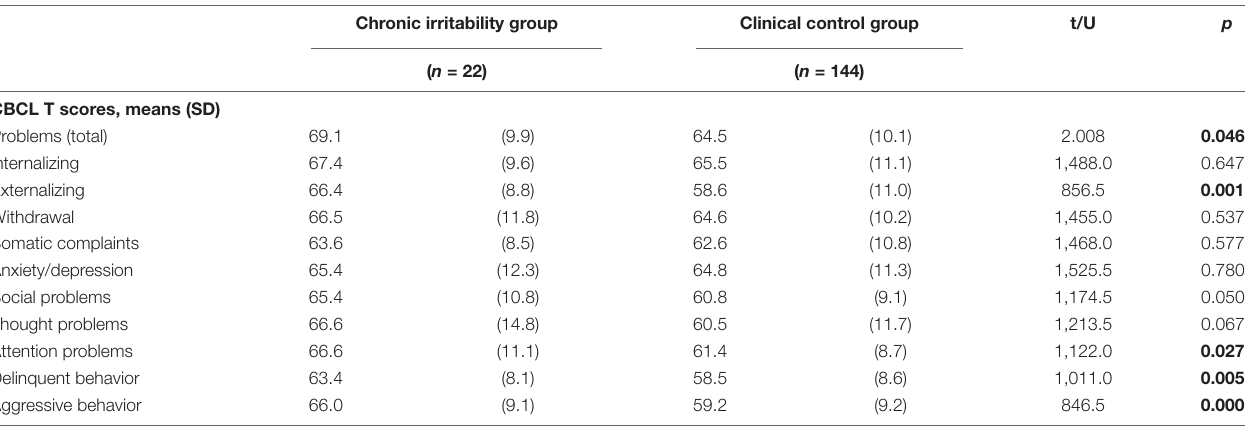
TABLE 2 | CBCL T scores for the chronic irritability and clinical control groups.